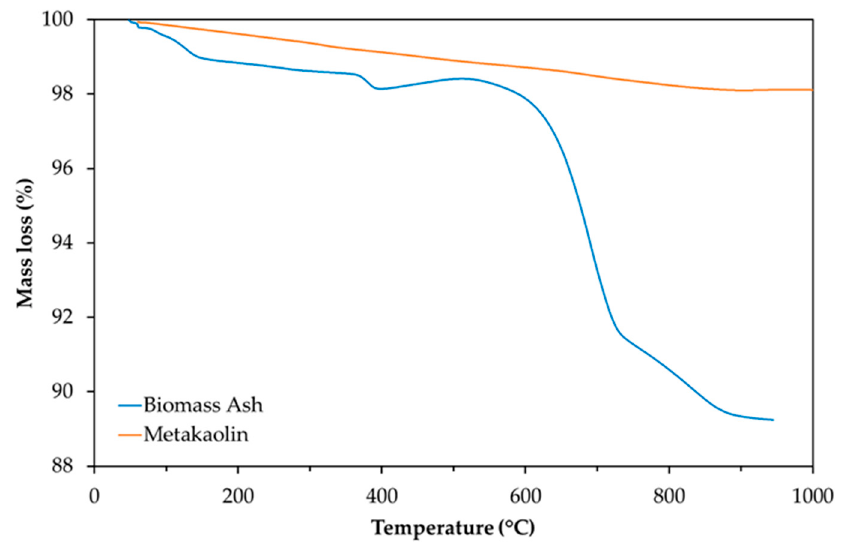
Figure 3. Thermogravimetric analysis (TGA) of metakaolin and biomass ash.